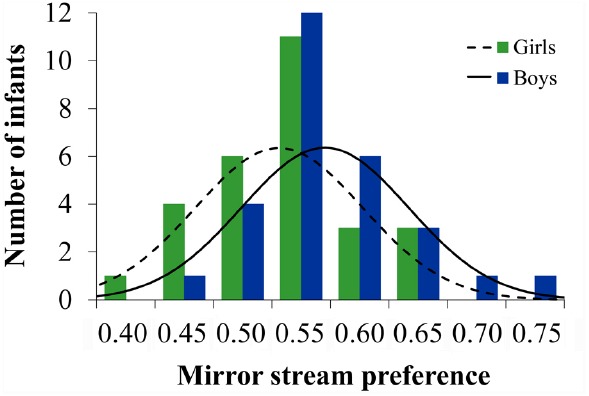
Histogram with Gaussian distribution of mental rotation performance for boys and girls. Mirror stream preference scores represent the mean proportion of looking time toward the mirror stream relative to overall looking time. Mirror stream preference scores above 0.50 reflect greater looking toward the mirror stream compared to the non-mirror stream (chance performance = 0.50).